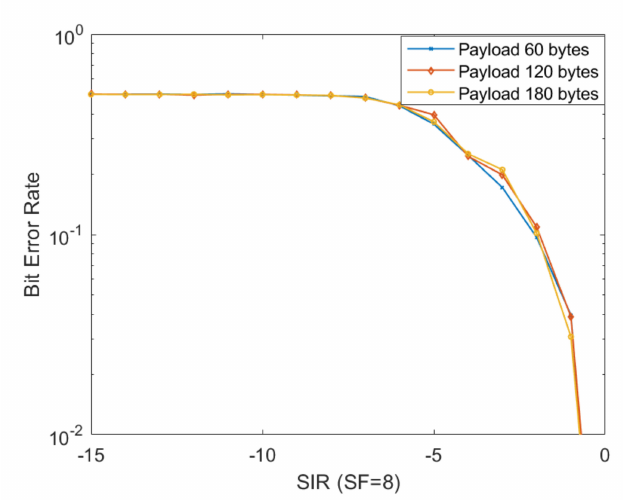
Figure 6. BER obtained by varying the payload size while maintaining the same BW value. The payload was varied from 60 bytes to 120 bytes and 180 bytes.